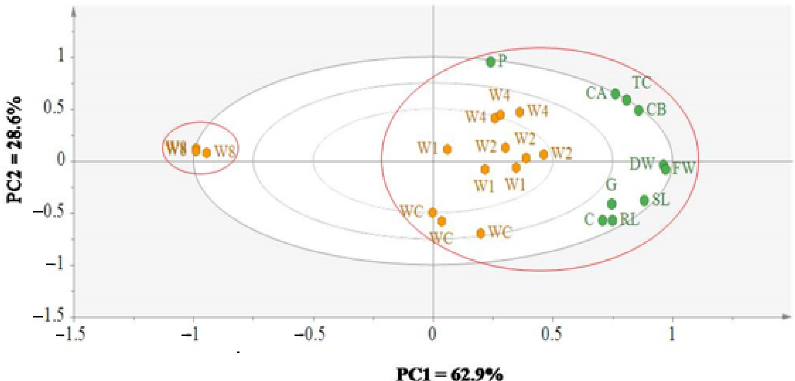
Figure 7. Effect of various concentrations of H. persicum aqueous extract on seed germination, seedling growth, and biochemical features in wheat. WC = Wheat control; W1 = 1% concentration; W2 = 2% concentration; W4 = 4% concentration; W8 = 8% concentration; TC = Total chlorophyll; CA = Chlorophyll a; CB = chlorophyll b; G = Germination percentage; DW = Dry weight; FW = Fresh weight; SL = Shoot length; RL = Root length; P = Proline; C = Carbohydrates.